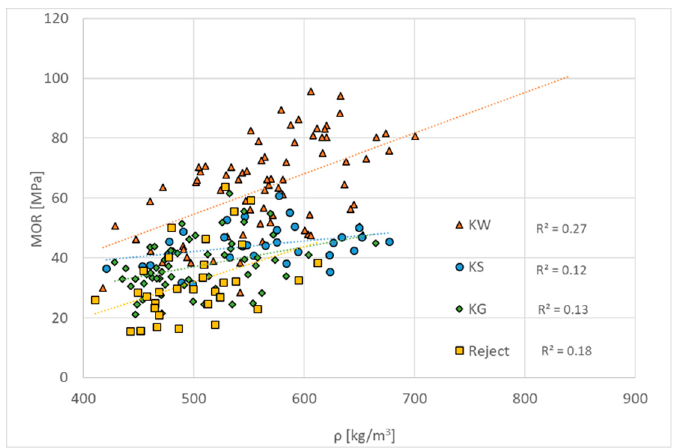
Figure 2. Correlations between the static bending strength and wood density, taking strength grades into account.